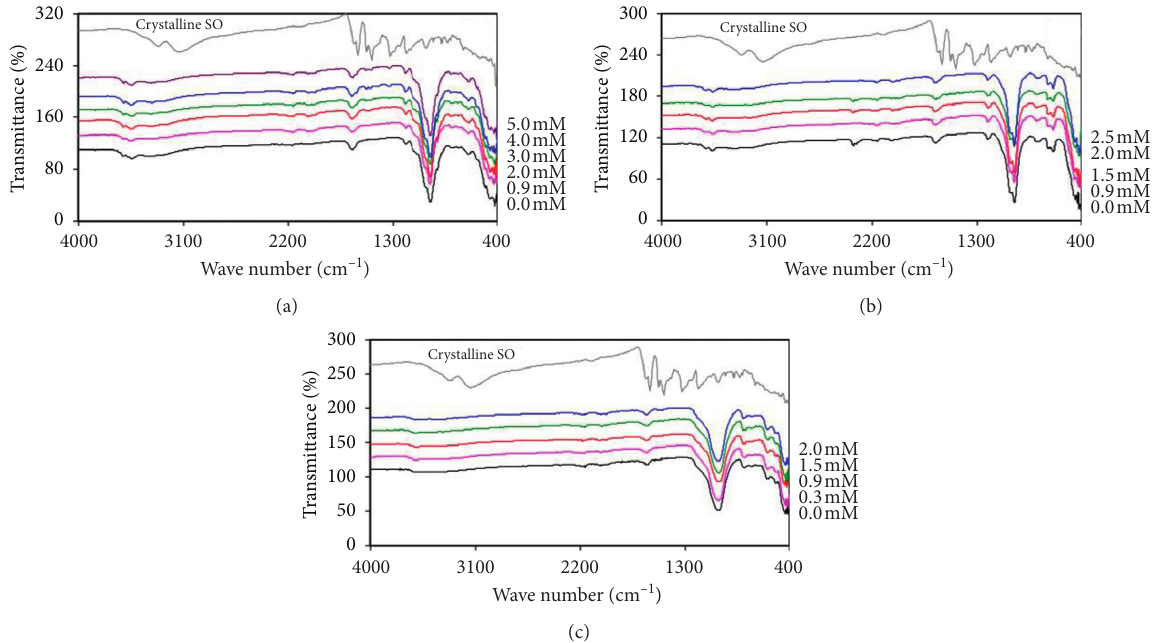
Figure 5: FTIR spectra of PAL (a), SEP (b), and ZEO (c) after SO sorption from different initial